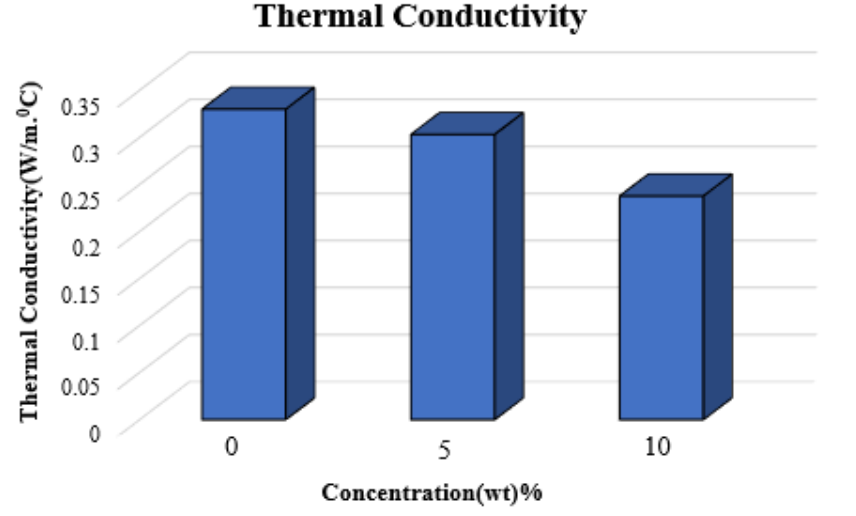
Figure 5: Mean values of thermal conductivity as a function of fiber concentration